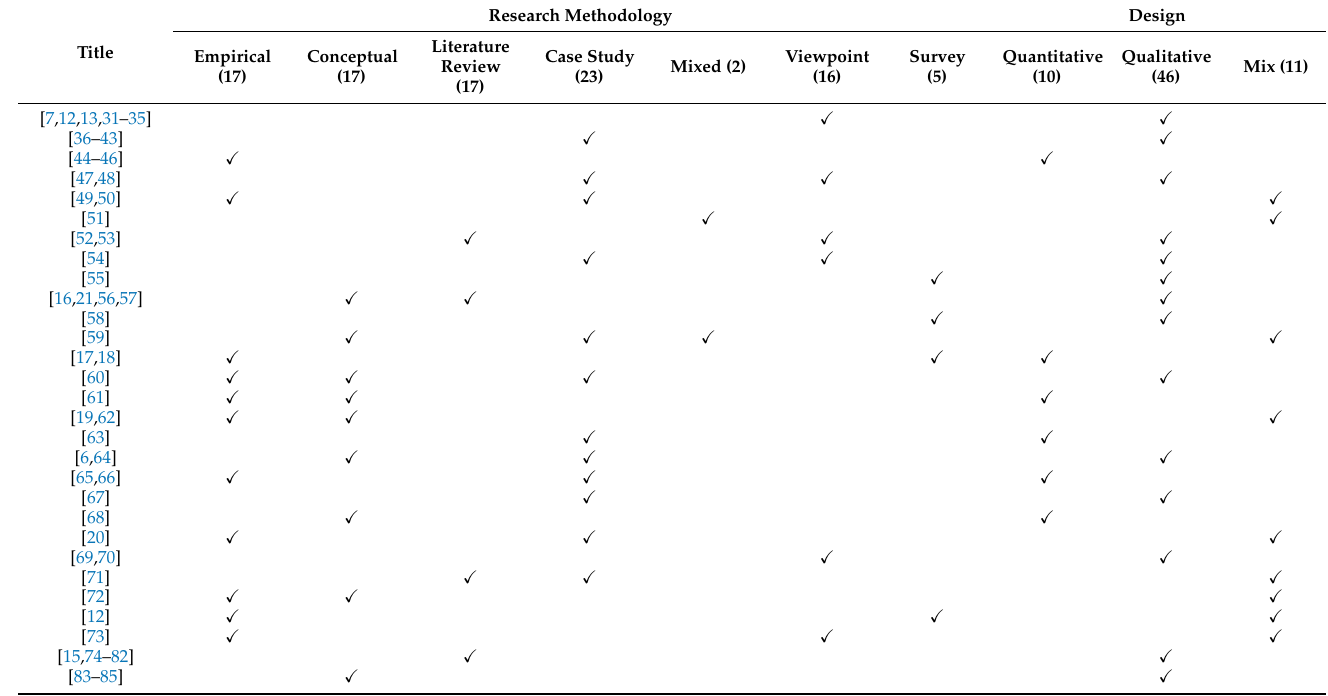
Table 5. Research Methodology and Design, Source: The